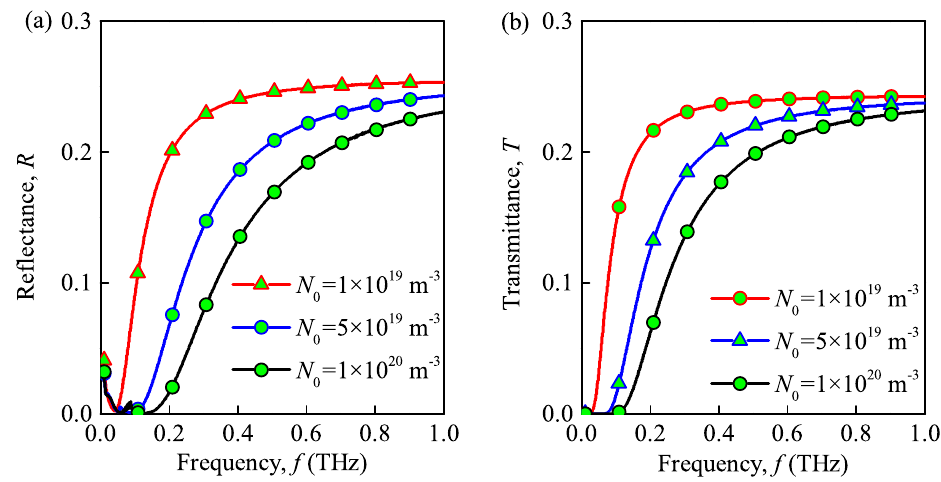
Figure 5. Reflectance ( a ) and transmittance versus ( b ) wave frequency under different maximal electron densities.